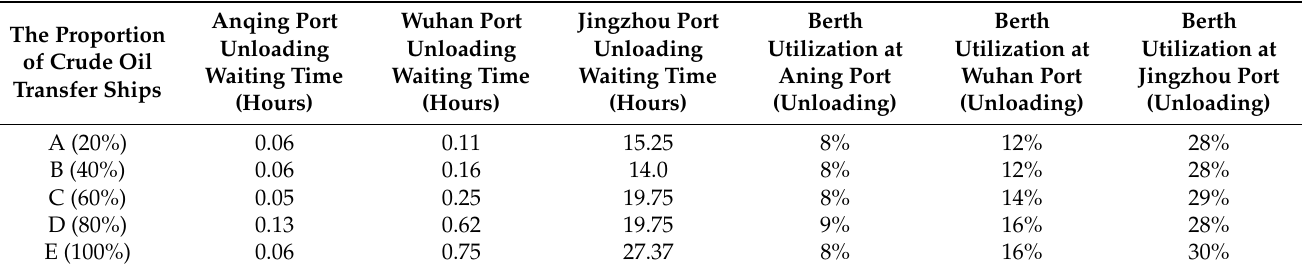
Table 2. The tanker waiting times and consumption nodes’ berth utilization